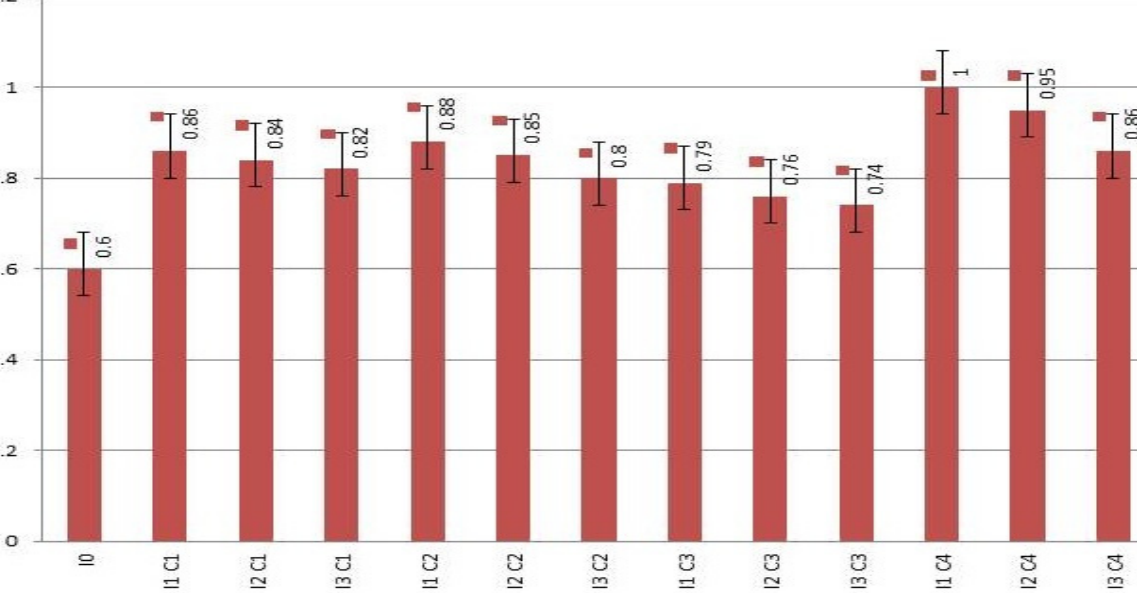
Figure 9. Relative quantification of gene POTT and tubulin in different irrigation levels at various crop phenological stages in apple (cv. Super Chief Sandidge).